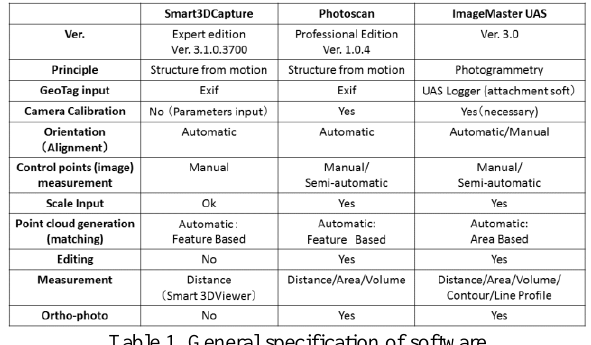
Table 1. General specification of software